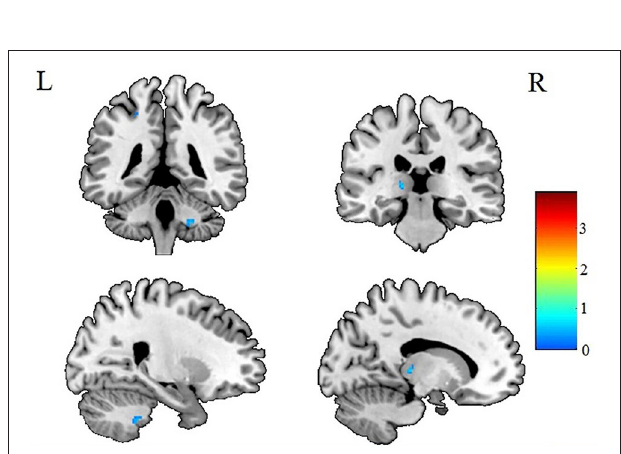
FIGURE 4 | Patients with IGE showed decreased AD (refer to color scale) in the WM of the right middle cerebellar peduncle and left thalamus compared with healthy controls after AlphaSim correction ( P < 0.05). AD, axial diffusivity; WM, white